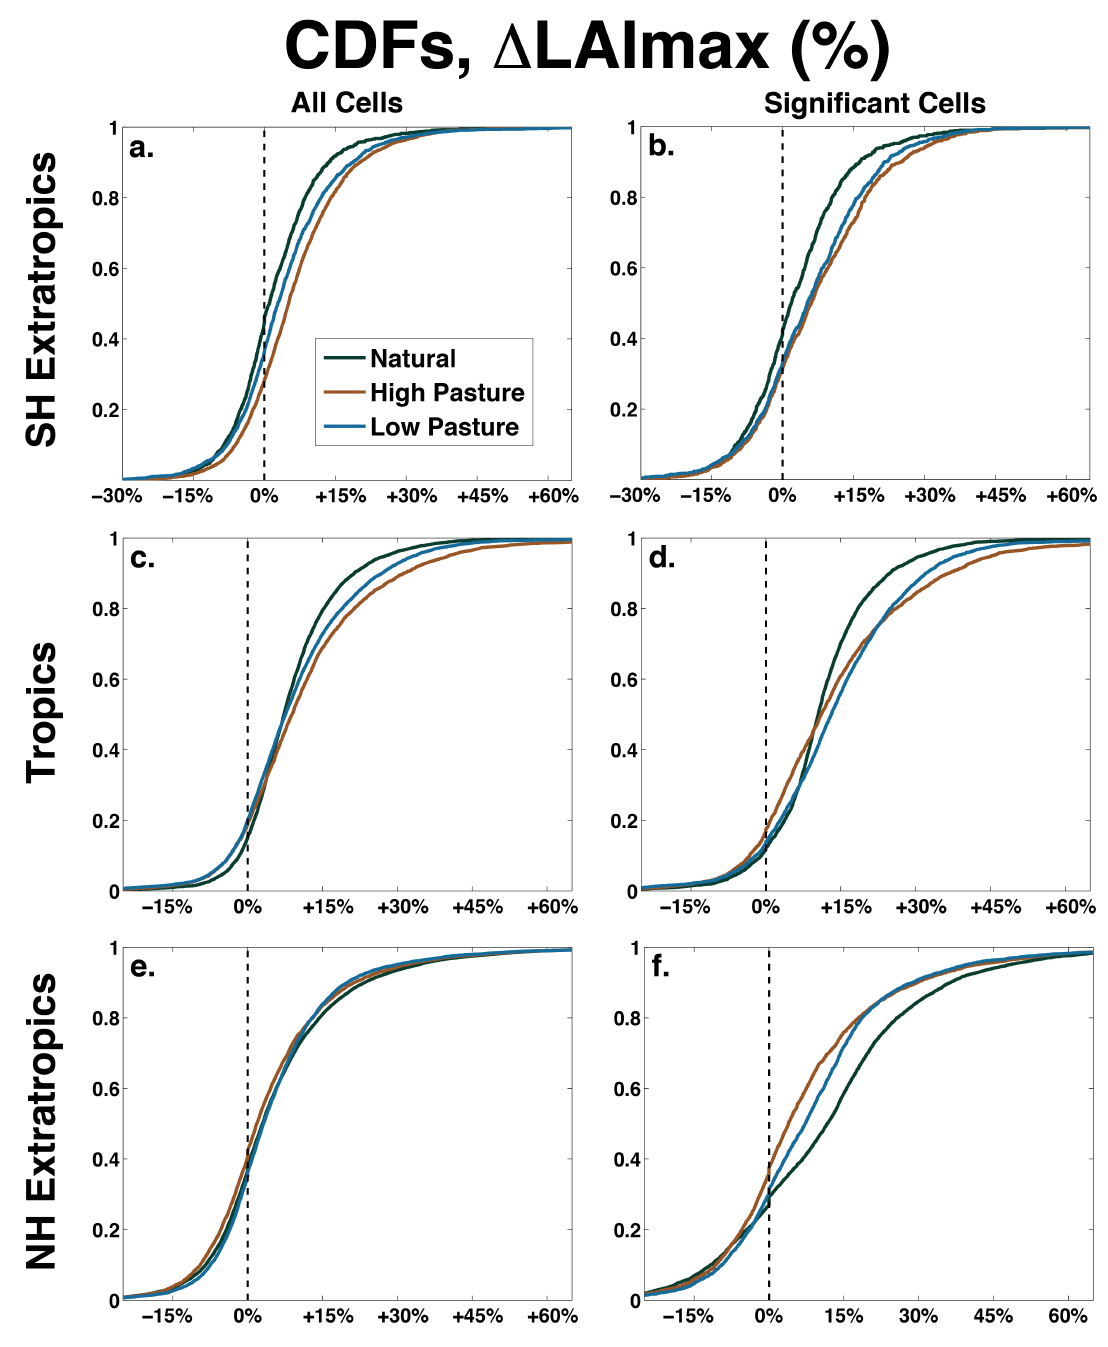
Figure 8. Cumulative distribution functions (CDFs) for percent changes in LAImax (1982–2008), stratified by latitudinal band and vegetation cover (natural, low-intensity pas- ture, and high-intensity pasture): the Southern Hemisphere extra-tropics (60 ◦ S–20 ◦ S; ( a , b )); the tropics (20 ◦ S–20 ◦ N; ( c , d )); and the Northern Hemisphere extra-tropics (20 ◦ N–60 ◦ N; ( e , f )). CDFs in the left column are for all cells of each land cover type; CDFs in the right column include only those cells that pass the three trend test